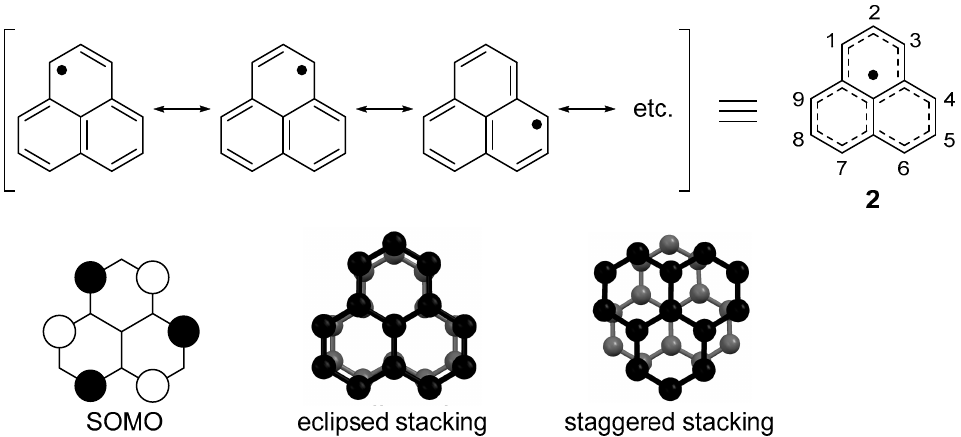
Figure 1. Resonance structure and singly occupied molecular orbital (SOMO) of phenalenyl radical ( 2 ).